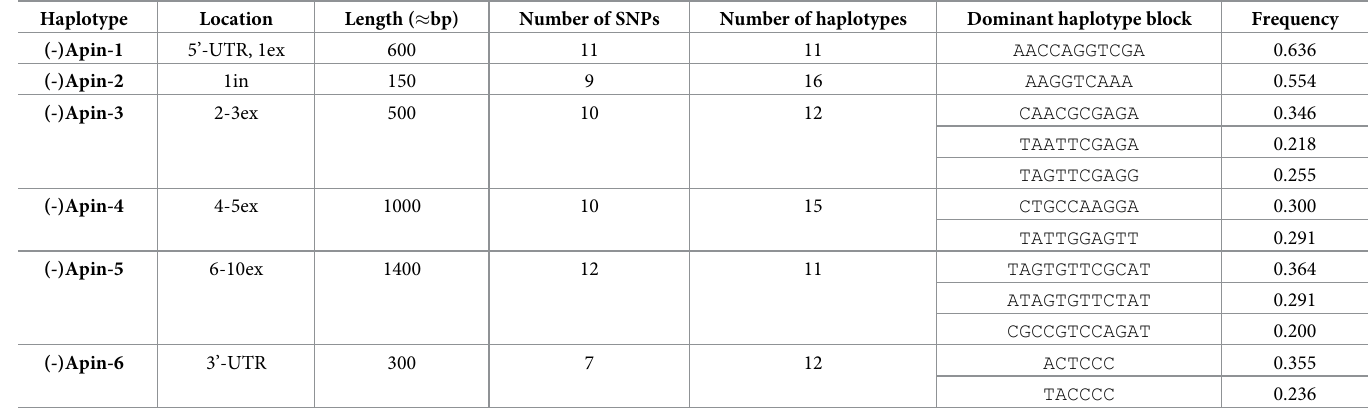
Table 3. PeTPS-(-)Apin gene haplotype blocks of the 110